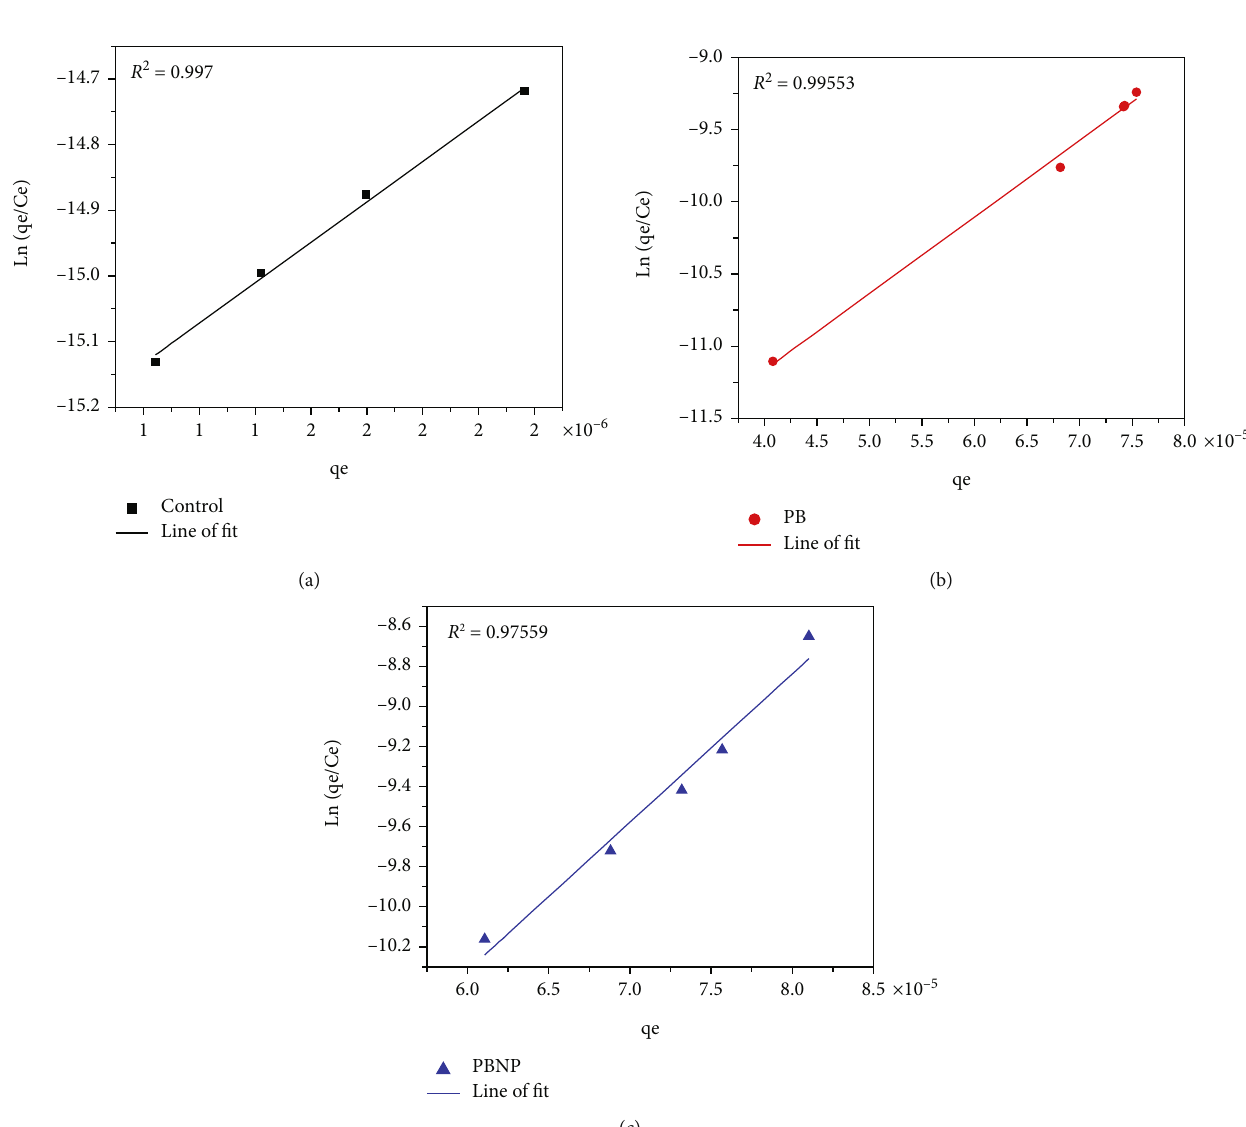
Figure 9: The Elovich isotherm plot of (a) control, (b) PB, and (c) PBNP